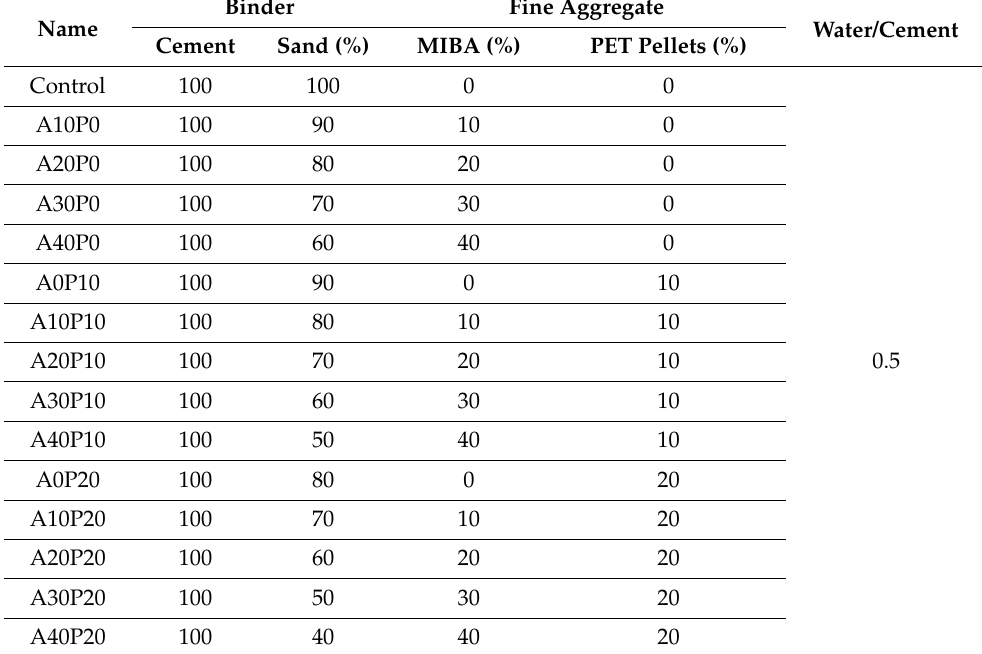
Table 1. Mortar formulations.